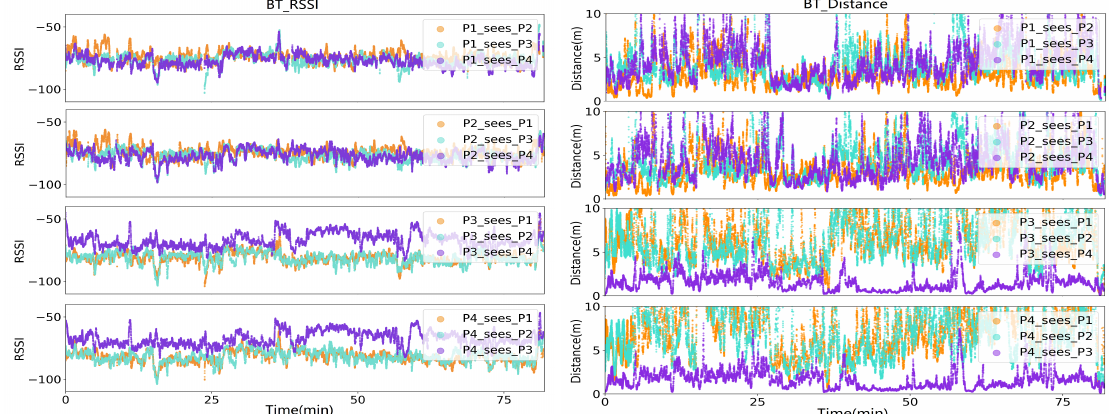
Figure 26. Bluetooth (BT) based Received Signal Strength Indicator (RSSI)/Distance information during the